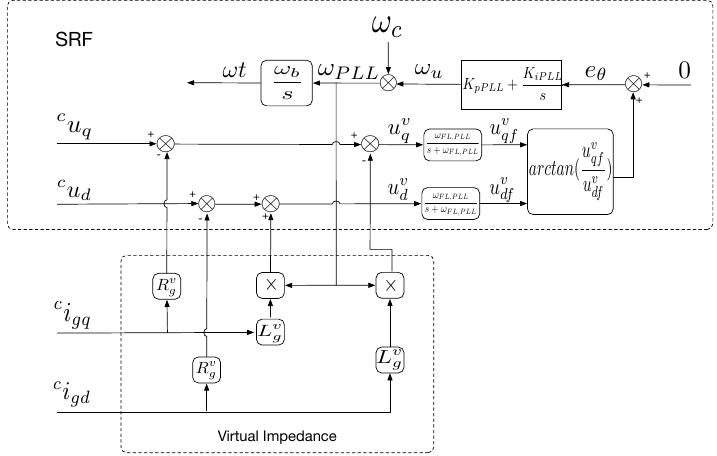
Figure 3. Block diagram of the impedance-conditioned PLL.